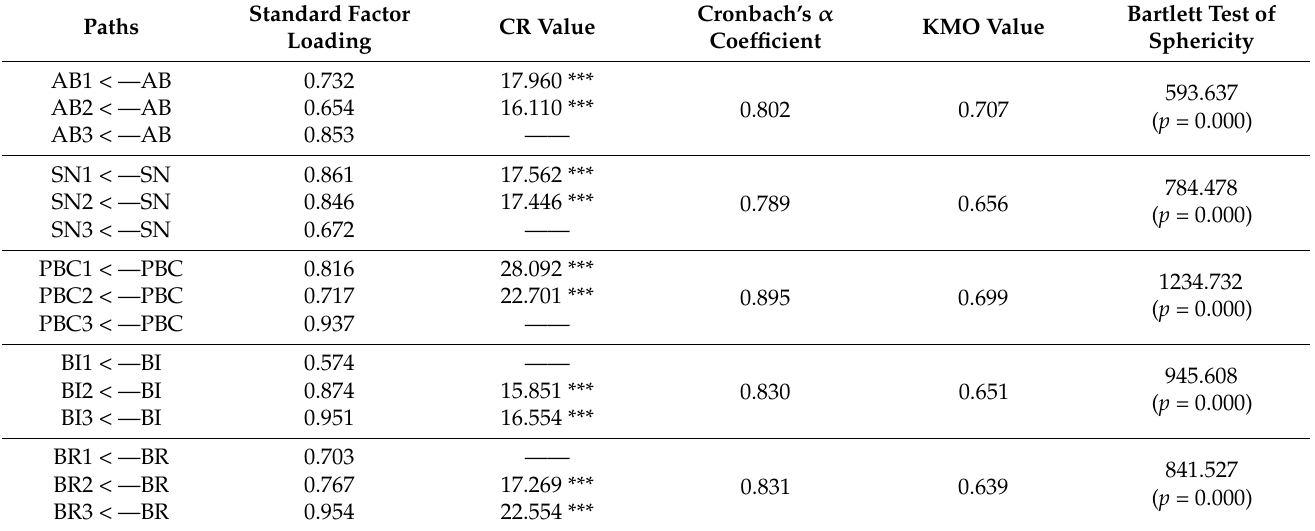
Table 4. Results of reliability and validity tests and factor